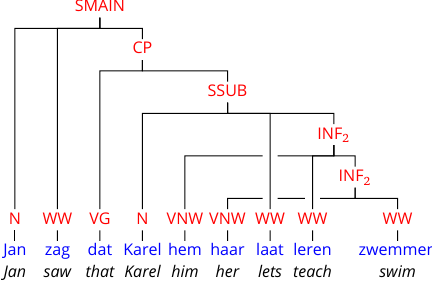
Cross-serial dependencies in Dutch expressed with discontinuous constituents